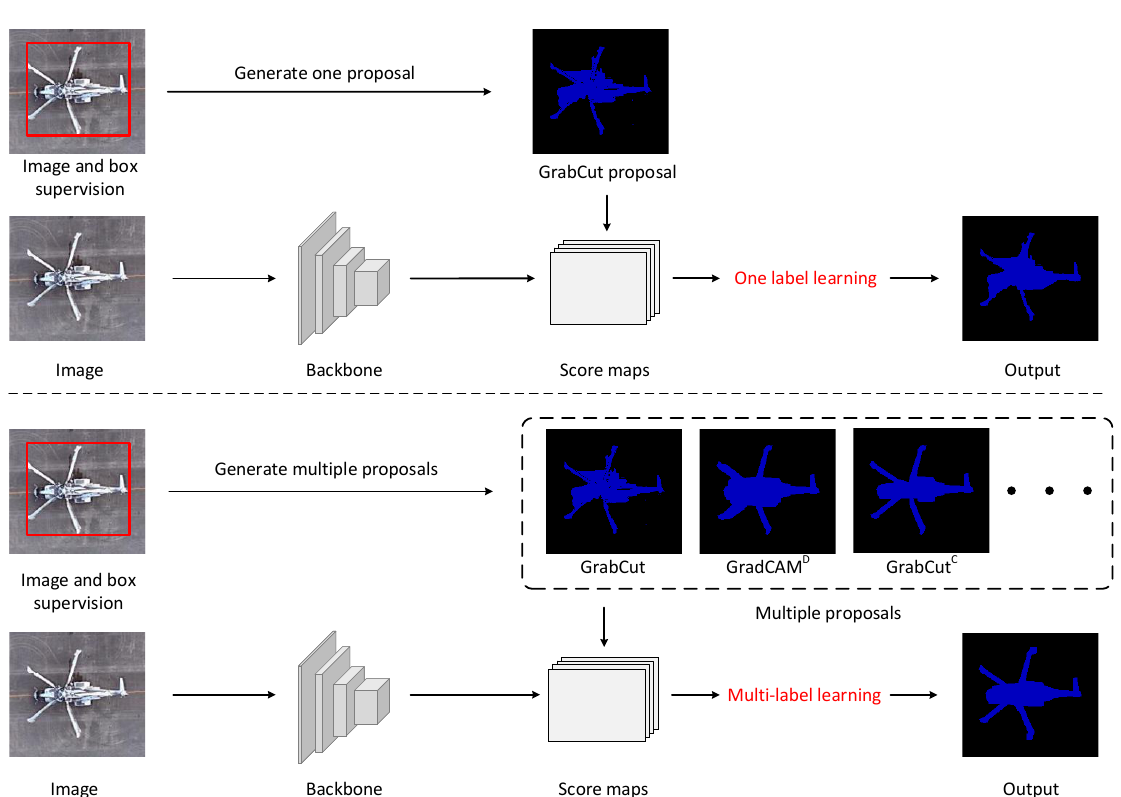
Figure 1. The overall pipeline of previous weakly supervised semantic segmentation methods (top) and our proposed JMLNet (bottom). Previous methods generate one specific proposal and use it in the training process. However, we first generate multiple proposals as multi-label supervision and use multi-label loss to train the segmentation model.